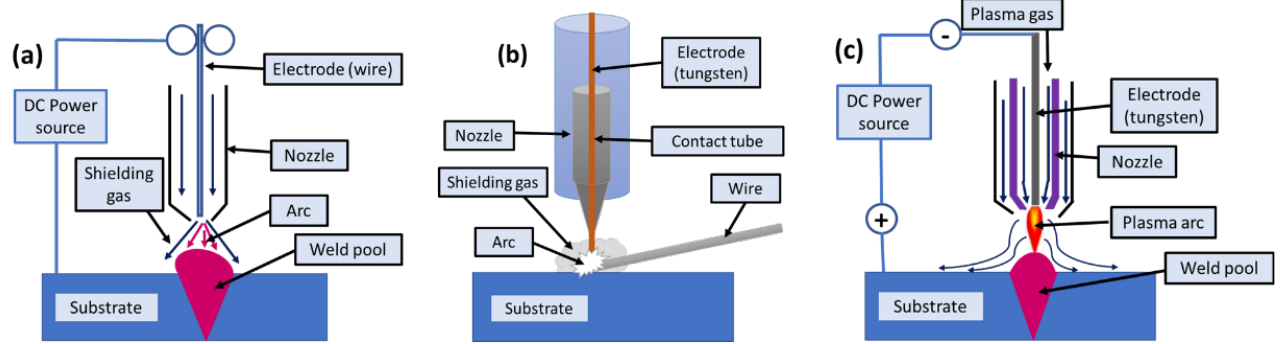
Figure 13. Wire arc additive manufacturing working principle using ( a ) MIG, ( b ) TIG, and ( c ) plasma arc welding [187].